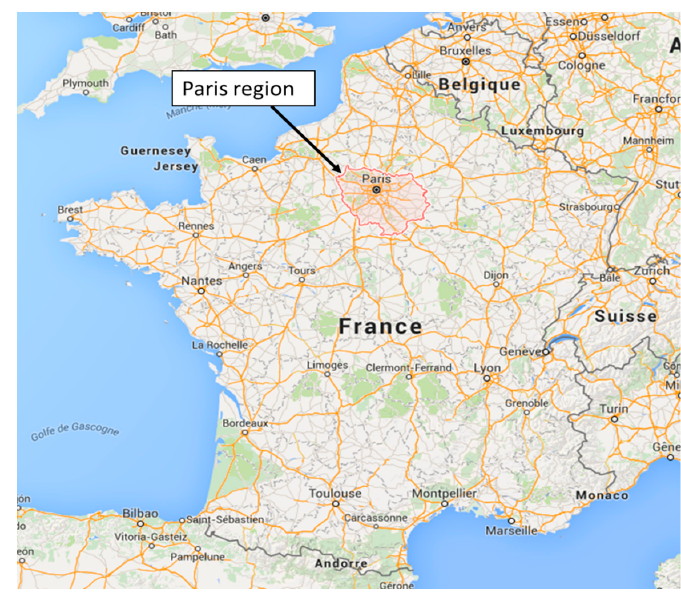
Figure 3. “Paris area” surrounded by a red circle. (Adapted from: GoogleMaps).